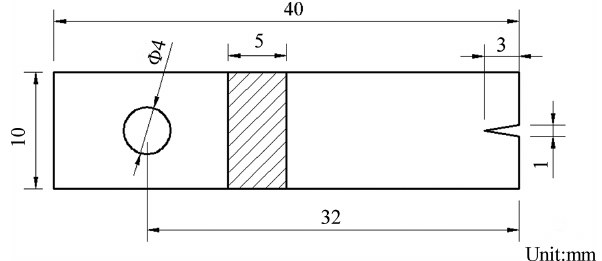
Figure 3: Fatigue specimen